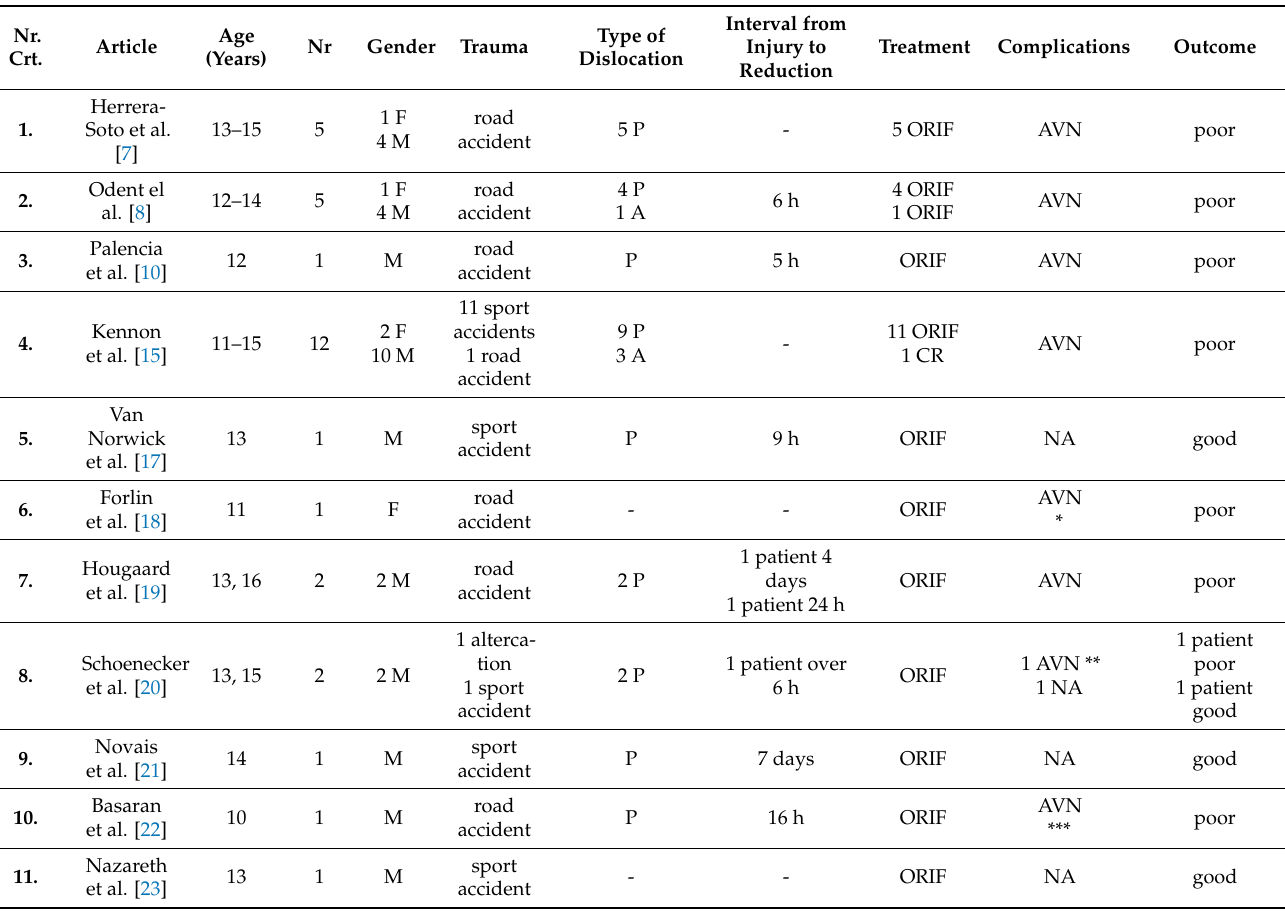
Figure 1. Literature review flow chart. Table 1. List of research